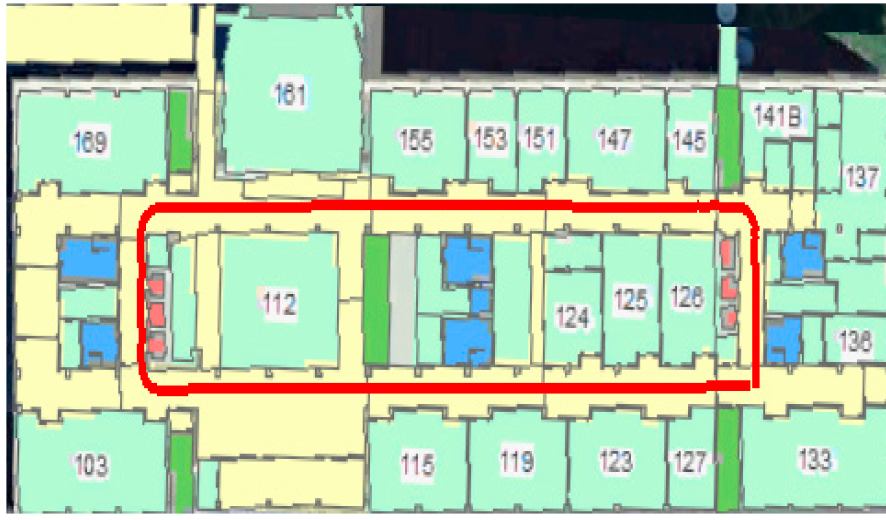
Figure 7. Reference trajectory at the energy environment experiential learning